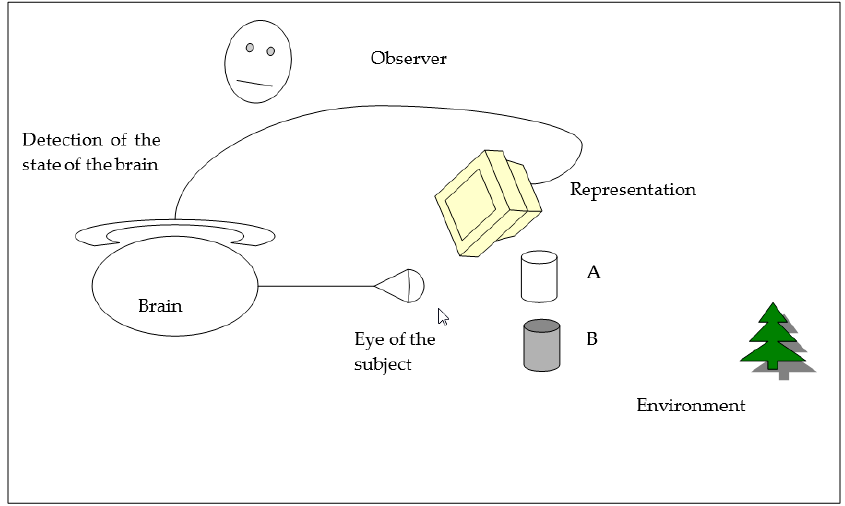
Figure 2. This is the same system as in Figure 1, except for one difference: now the human actor who has to decide whether to take cup A or B can simultaneously watch a screen which would represent to himself/herself the inner state of his/her brain. The human actor would know at least about two seconds in advance which of the two possibilities, A or B, his/her brain would select. Due to his/her consciousness, however, the human actor is now able to refute any predetermined decision of his/her brain.